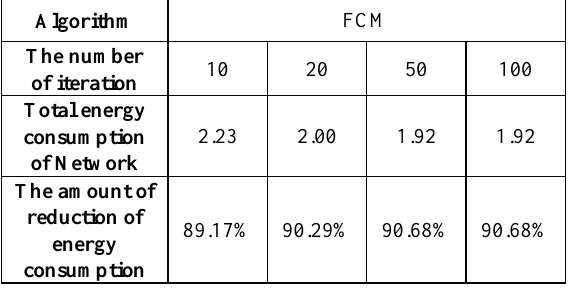
Table 2. The performance of the FCM algorithm in decreasing